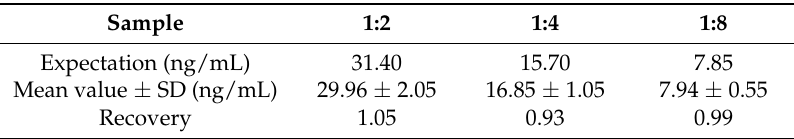
Table 1. Accuracy results of the CM-EU test strips ( n = 3).